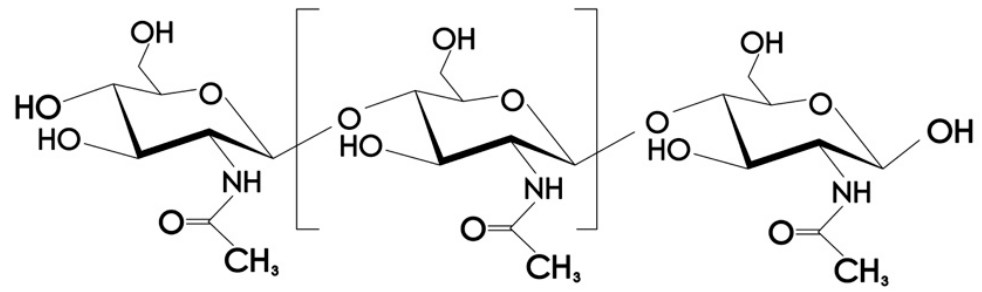
Figure 3. Molecular formula of chitosan.